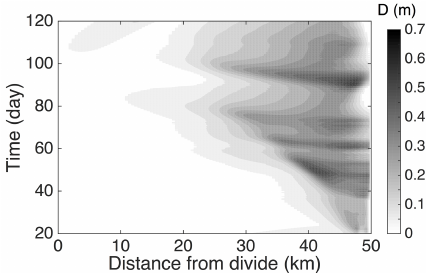
Figure 13. Maximum particle diameter for which movement would be initiated in simulation T_2008 assuming τ ∗ c = 0 . 03 (see Table 4 and Fig.